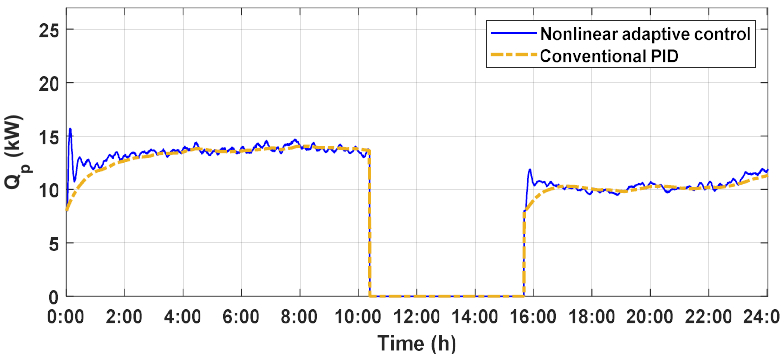
Figure 16. The corresponding response of control input.